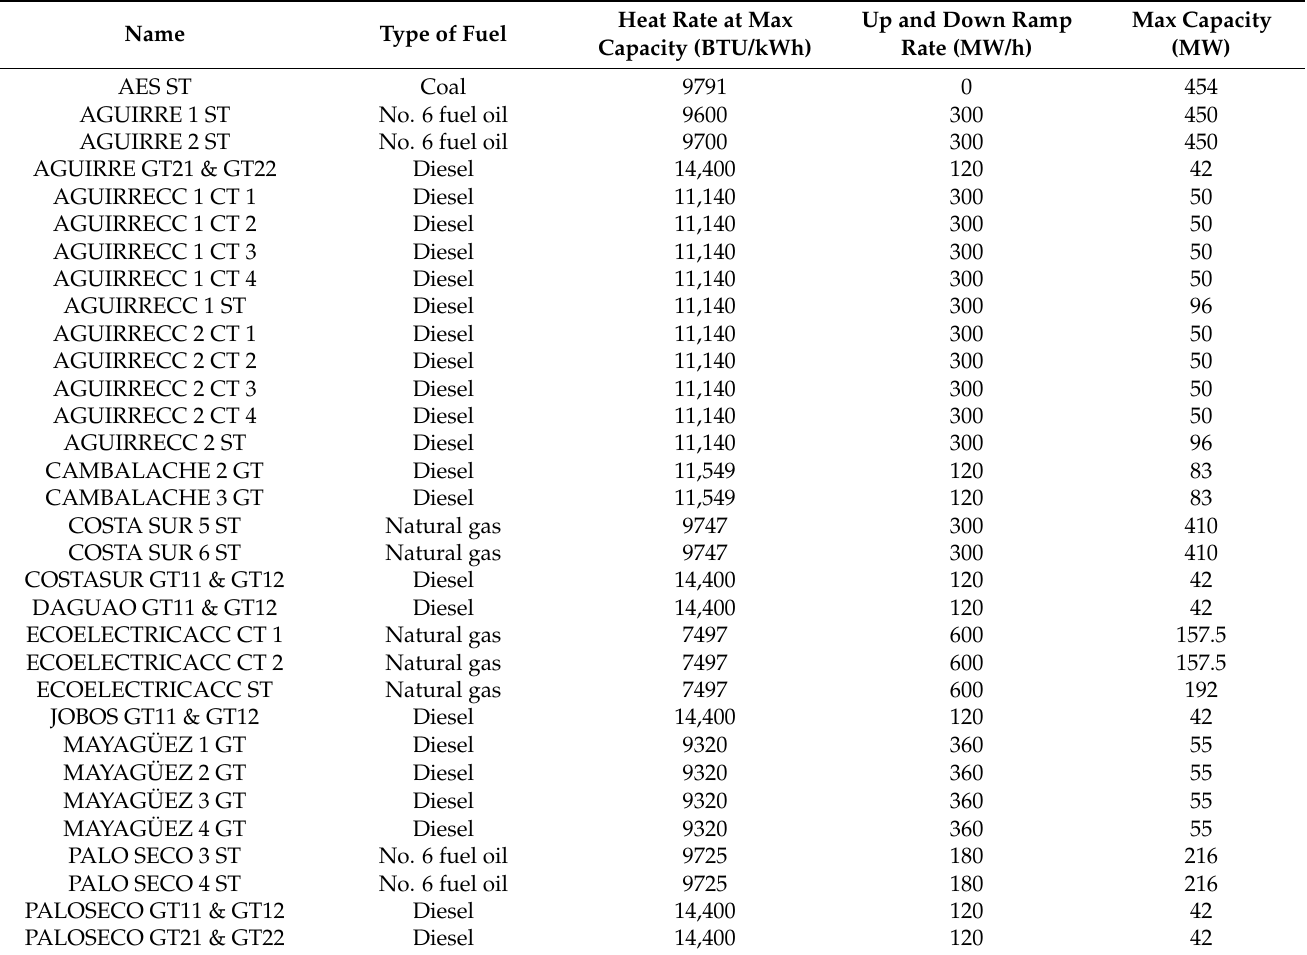
Table 1. Existing conventional generators in Puerto